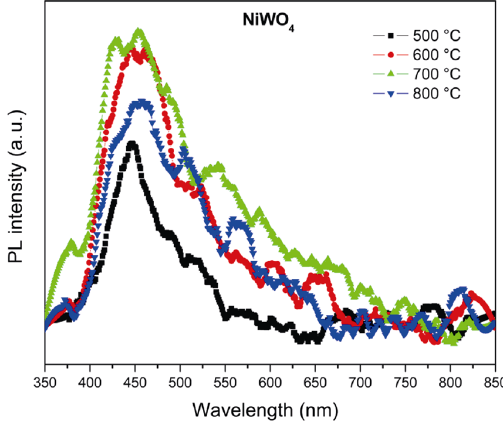
Fig. 8 PL emission spectra at room temperature from the NiWO 4 powders calcined at 500–800 ℃ for 2